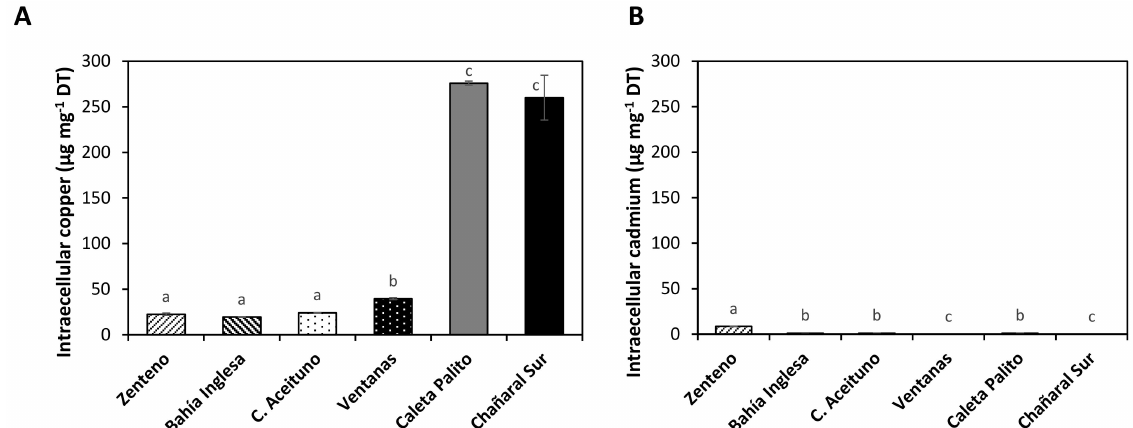
Figure 2. Level of intracellular copper ( A ) and cadmium ( B ) in algae of control sites and copper-polluted sites ( A ). The levels of intracellular copper and cadmium are expressed in micromoles per milligram of dry tissue (DT). Bars represent mean values of three independent replicates ± SD. Letters indicate significant differences ( p < 0.05).